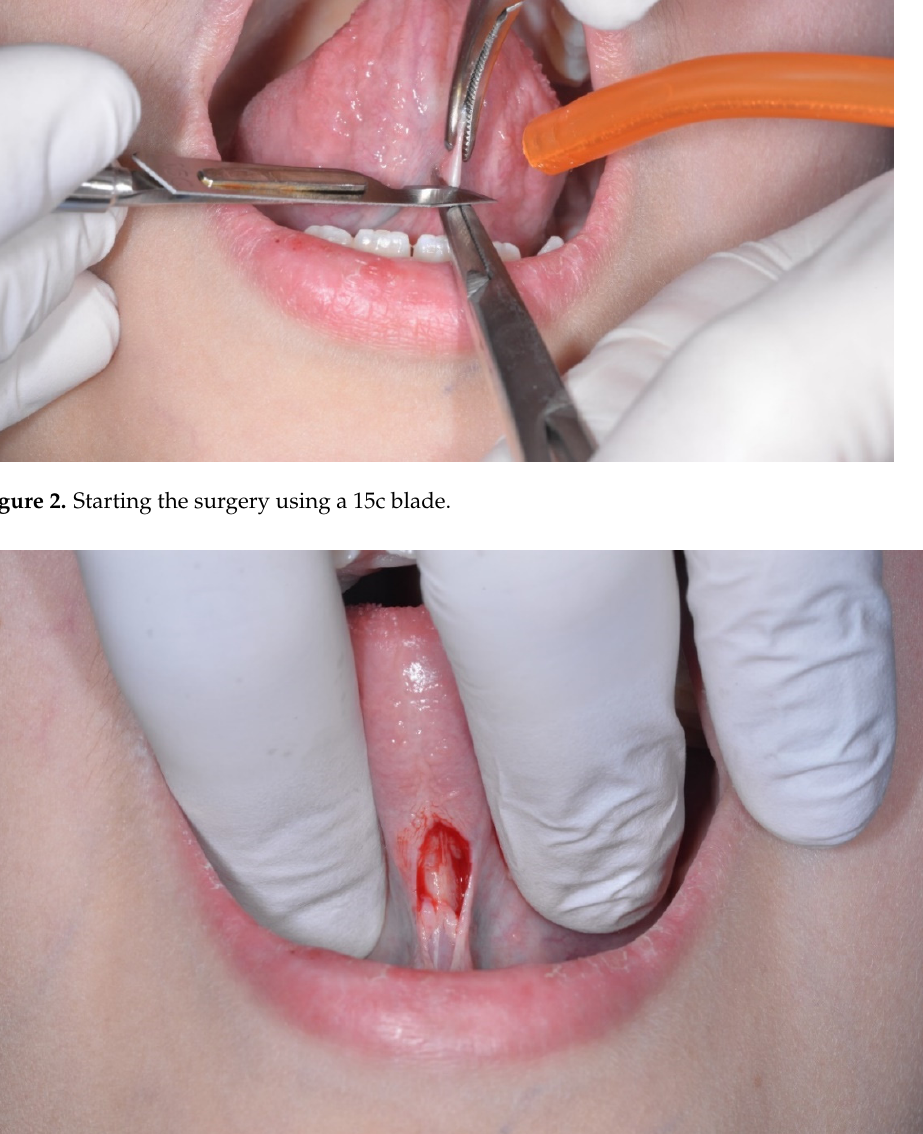
Figure 3. Evidencing the diamond-shaped pattern of the incision. The bleeding was controlled using the Metzebaum’s scissors, and the mucous layer was separated using a scissor from the underlying muscle layers, to make sure there would be no tension on the suture (Figure 4).